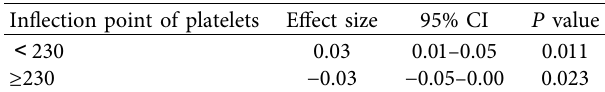
Nonadjusted model adjusted for none. Adjust I model adjusted for age and sex. Adjust II model adjusted for age and Sex; BMI; educational level; smoking; alcohol consumption; valvular disease; hypertension; diabetes mellitus; heart failure; coronary artery disease; myocardial infarction; hyperlipidemia; cerebral infarction history; aspirin; warfarin; clopidogrel; rivashaban; type of AF; duration of AF; Hb; RBC; PT; INR; APTT; D-dimer; FT3; FT4; TSH; creatinine; urea; UA; AST; ALT; lipoprotein; TC; TG; HDL; LDL; LVEF. Table 4: Results of platelet count and cognitive function using two- piecewise linear